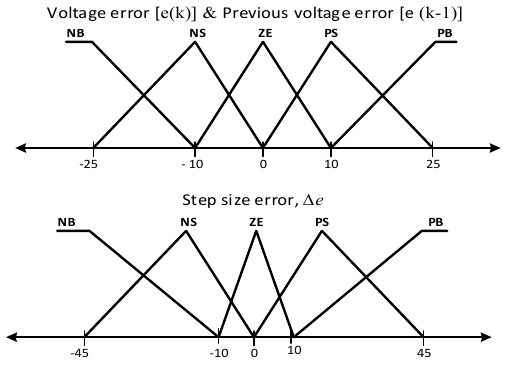
Figure 6. Membership functions for change of voltage error, previous voltage error, and step size error.